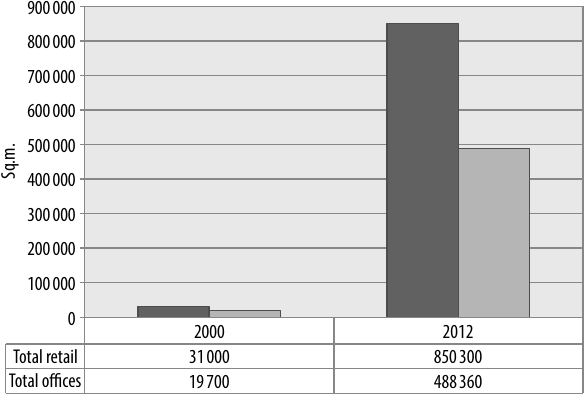
Fig. 1. Commercial property space